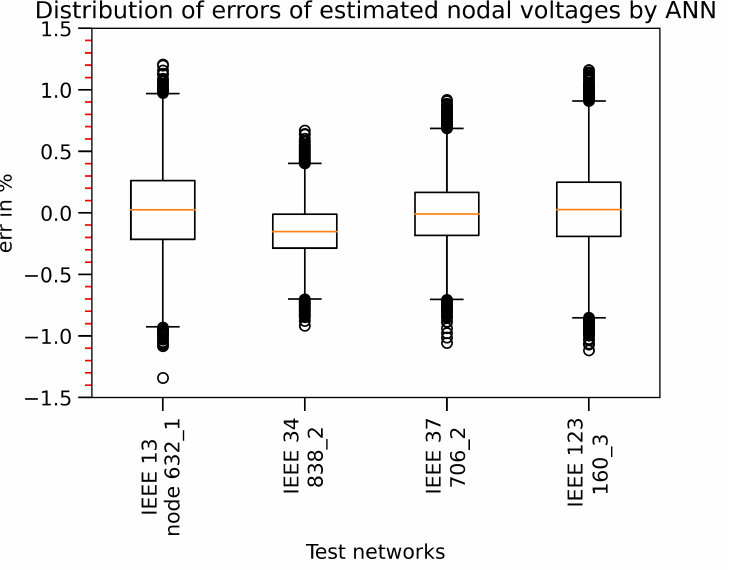
Figure 5. Box plot of the error distributions in the network nodes for the tested systems (nodal voltage magnitudes estimated by Step